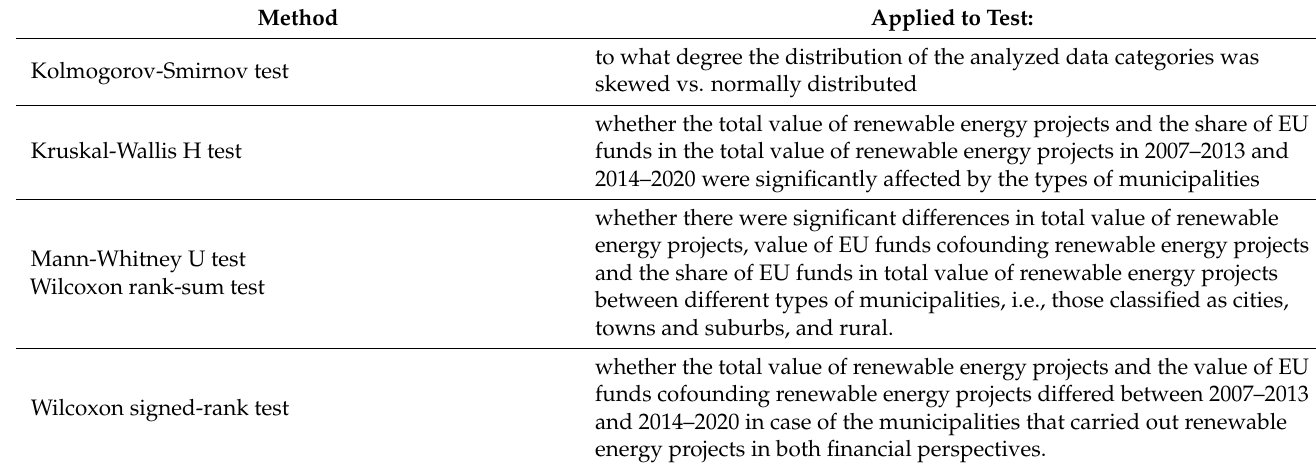
Table 2. Statistical methods and their